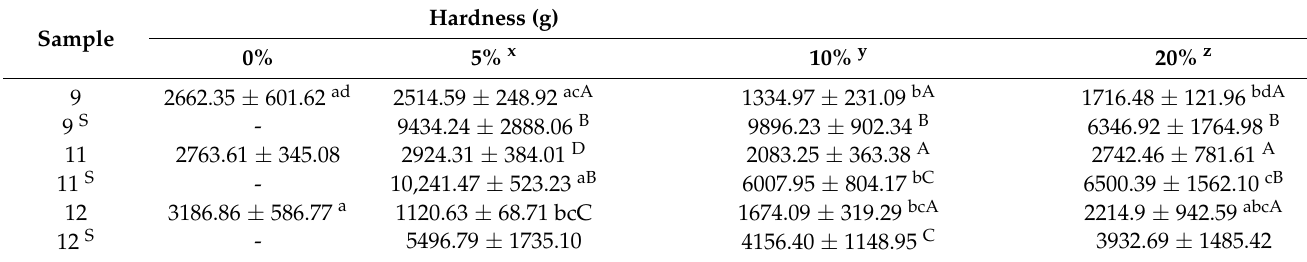
Table 8. The texture of samples containing xanthan with different addition of grape seed flour.